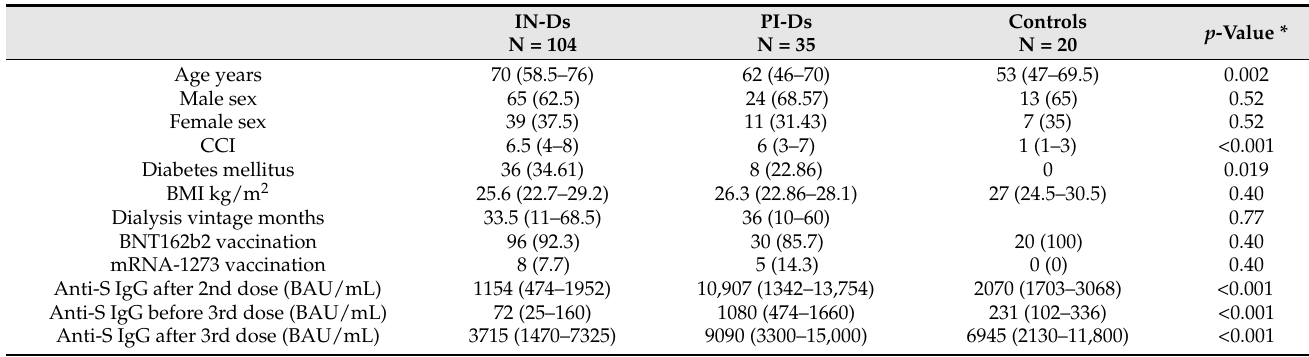
Table 2. Patient characteristics (protocol 2).